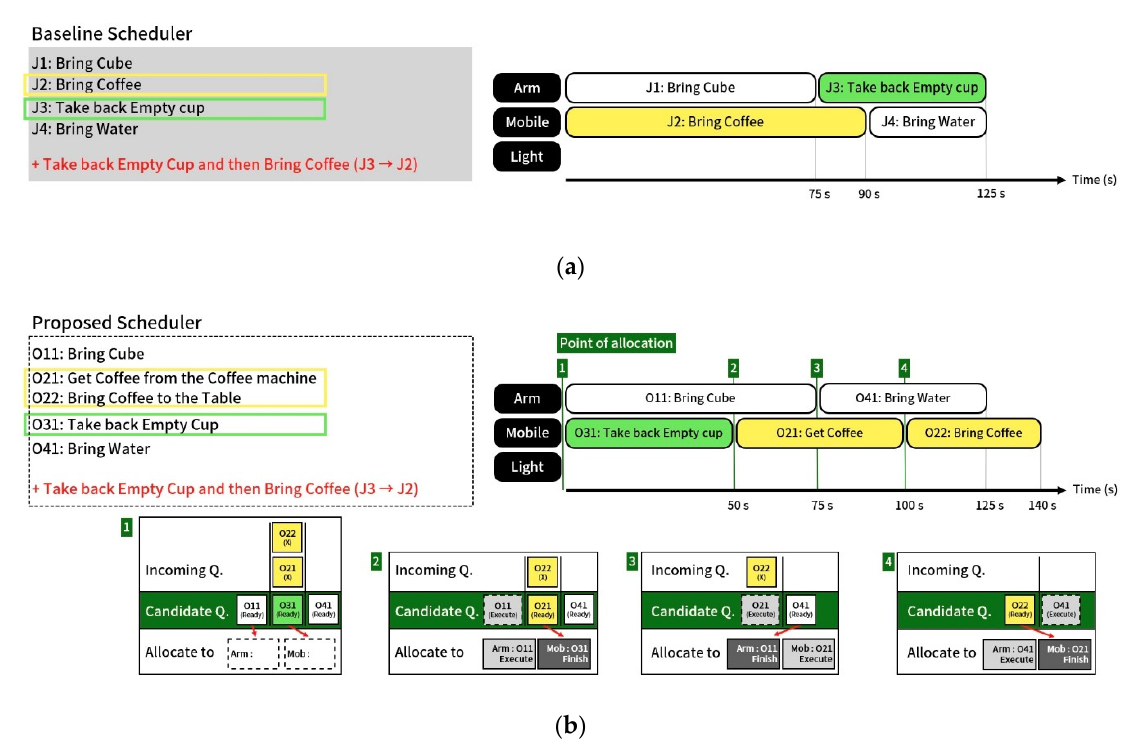
Figure 6. User requests to change the order of service: ( a ) the baseline scheduler and ( b ) the proposed scheduler.